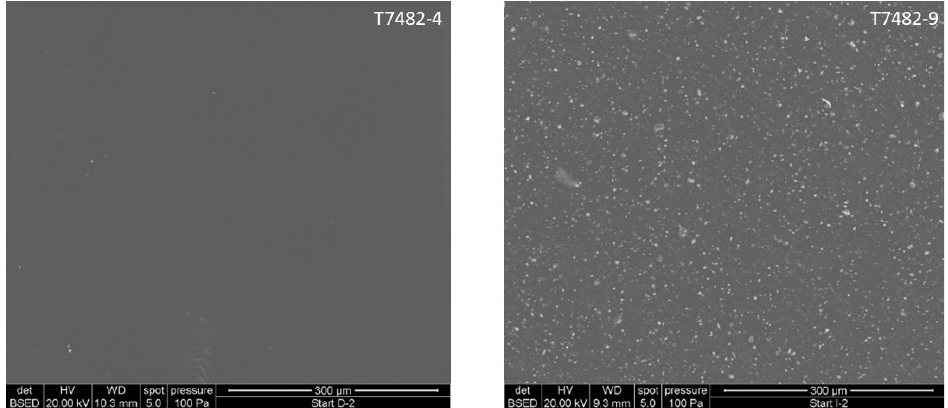
Figure 14. SEM of unaged membranes T7482-4 ( left ) and T7482-9 ( right ).